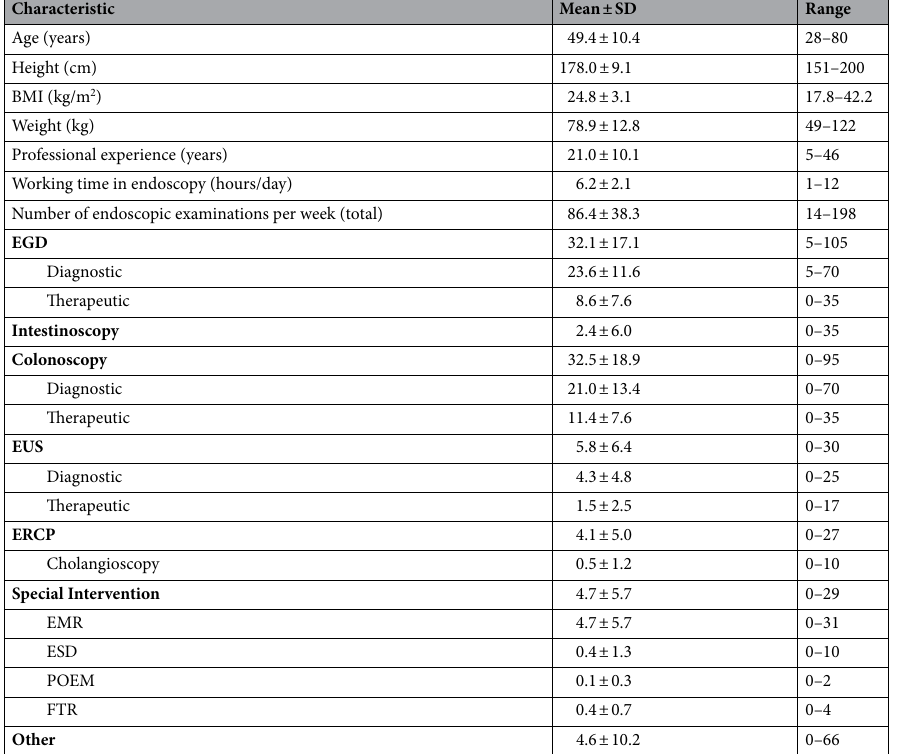
Table 2. Demographic data of participating endoscopists ( n = 151). EGD Oesophagogastroduodenoscopy, ERCP endoscopic retrograde cholangiopancreatography, EUS endoscopic ultrasound, ESD endoscopic submucosal dissection, EMR endoscopic mucosal resection, POEM peroral endoscopic myotomy, FTR full- thickness resection, BMI body mass